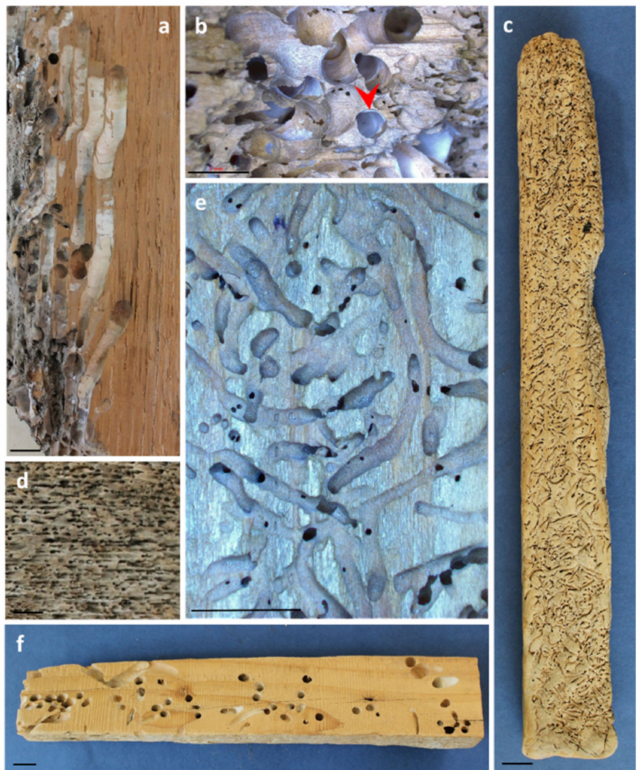
Figure 6. Galleries bored by marine wood borers. ( a ) Tangential cut of a wooden piece showing internal galleries bored by marine molluscs known as ‘shipworms’ (Teredinidae). Note that galleries follow the fibre direction and are covered by a calcareous lining. Bar = 10 mm. ( b ) Detail of the galleries bored by shipworms showing the calcareous layer deposited by the mollusc in the galleries (arrowhead). Bar = 5 mm. ( c ) Wooden piece attacked by crustaceans known as ‘gribbles’ (Limnoriidae) and eroded by weathering, leaving internal galleries visible. Note that galleries are superficial and follow any direction. Bar = 10 mm. ( d ) Detail of the exit holes of gribbles in wood. Bar = 10 mm. ( e ) Detail of the tunnels bored by gribbles. Bar = 5 mm. ( f ) External aspect of a wood attacked by shipworms showing entrance holes. Bar = 10